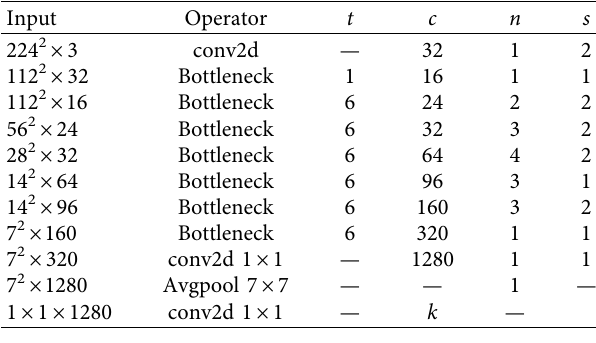
Table 1: Structure of MobileNetV2 network.